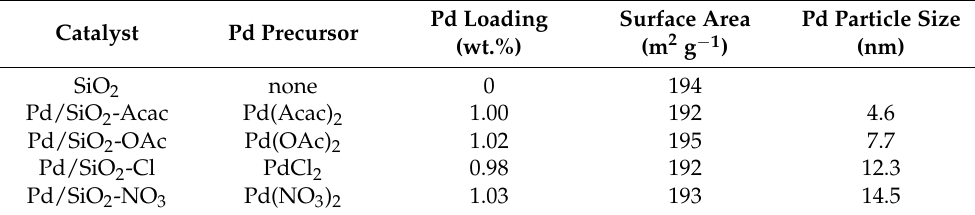
Table 1. Structural properties of the Pd/SiO 2 catalysts prepared by the dry ball-milling method with different Pd